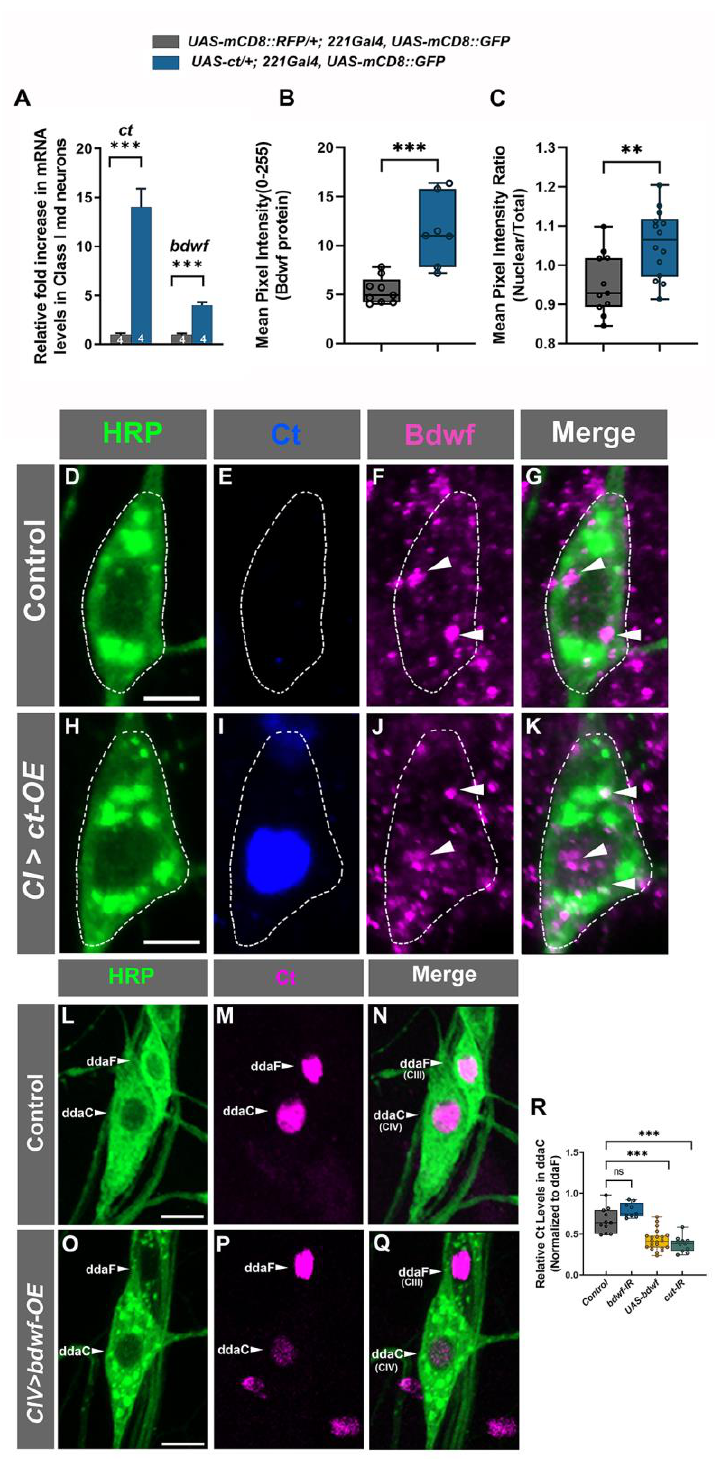
Figure 4. Cut and Bdwf reciprocally regulate one another. ( A – K ) Cut positively regulates Bdwf expression. Immunohistochemical labeling of wild-type ( D – G ) and ectopically Cut expressing ( H – K ) ventral CI md neurons immunolabeled with HRP (green), Cut (blue) and Bdwf (magenta) antibodies. White dotted lines outline the CI md neuron cell bodies and white arrowheads point to punctate Bdwf expression in the nucleus and cytoplasm. ( L – Q ) Bdwf negatively regulates Cut expression. Compared to wild-type ( L – N ), Bdwf overexpression results in a strong and significant suppression of Cut immunostaining levels in CIV ddaC neurons ( O – Q ) immunolabeled with HRP (green) and Cut (magenta). Scale bar, 5 µm. ( A ) RT-PCR quantification of relative mRNA levels of